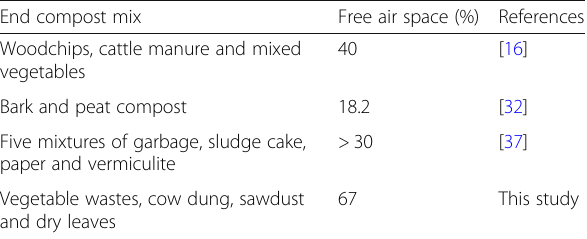
Table 4 Percentage of free air space occupied in the different compost mixtures at the end of treatment